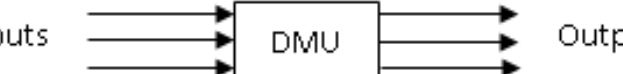
Figure 2. Role of Inputs and